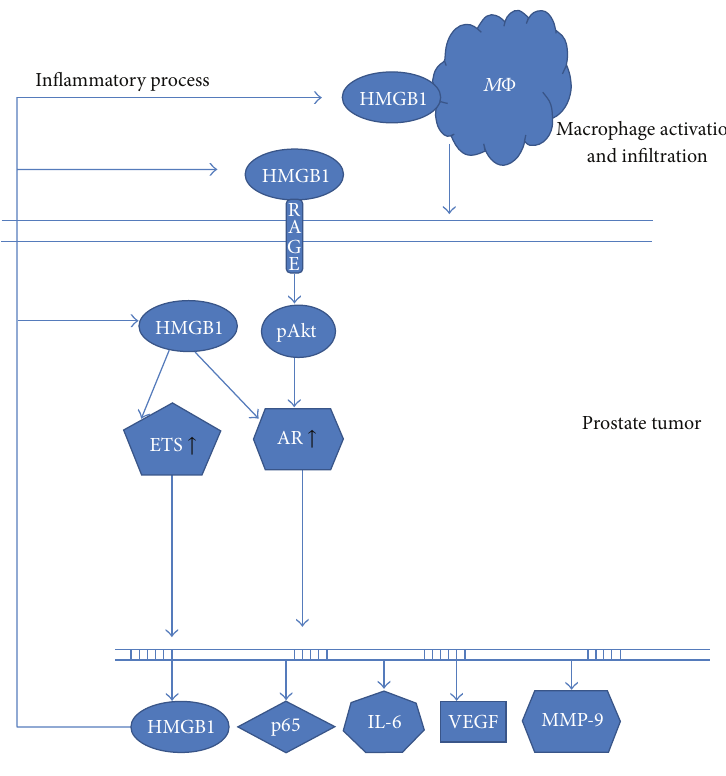
Figure 1: Proposed model of HMGB1 mediated prostate cancer